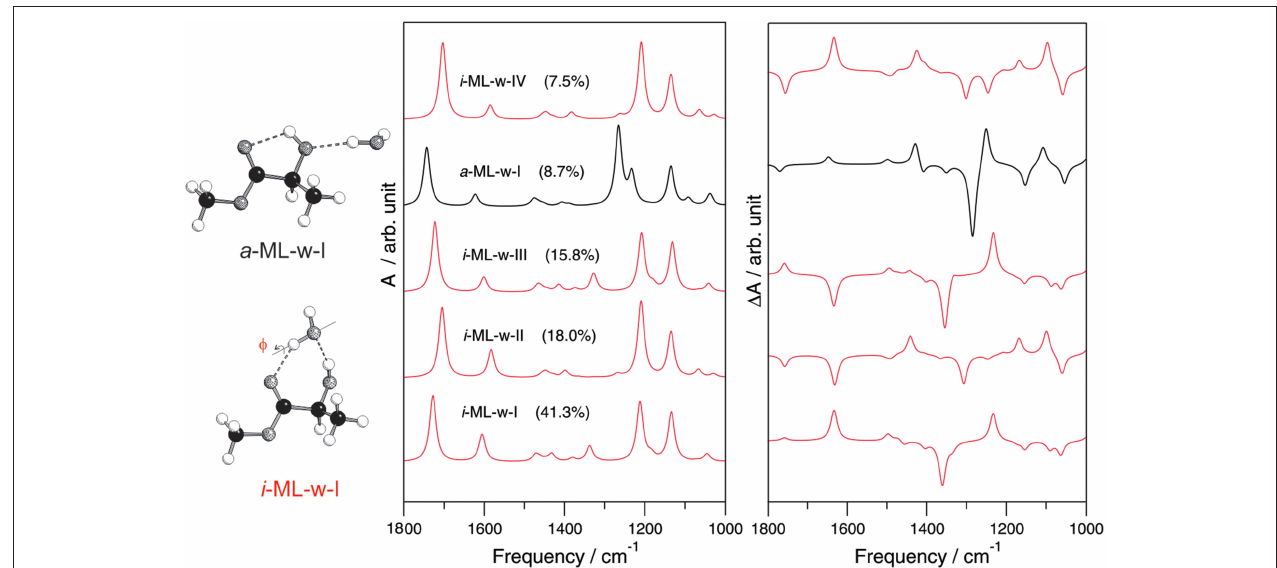
FIGURE 8 | The simulated IR and VCD spectra of the five most stable conformers of the 1:1 ML-water complex. The insertion and addition binding topologies of the ML-water complex are shown on the left. Reprinted with permission from Losada and Xu (2007). Copyright 2007, The Royal Society of